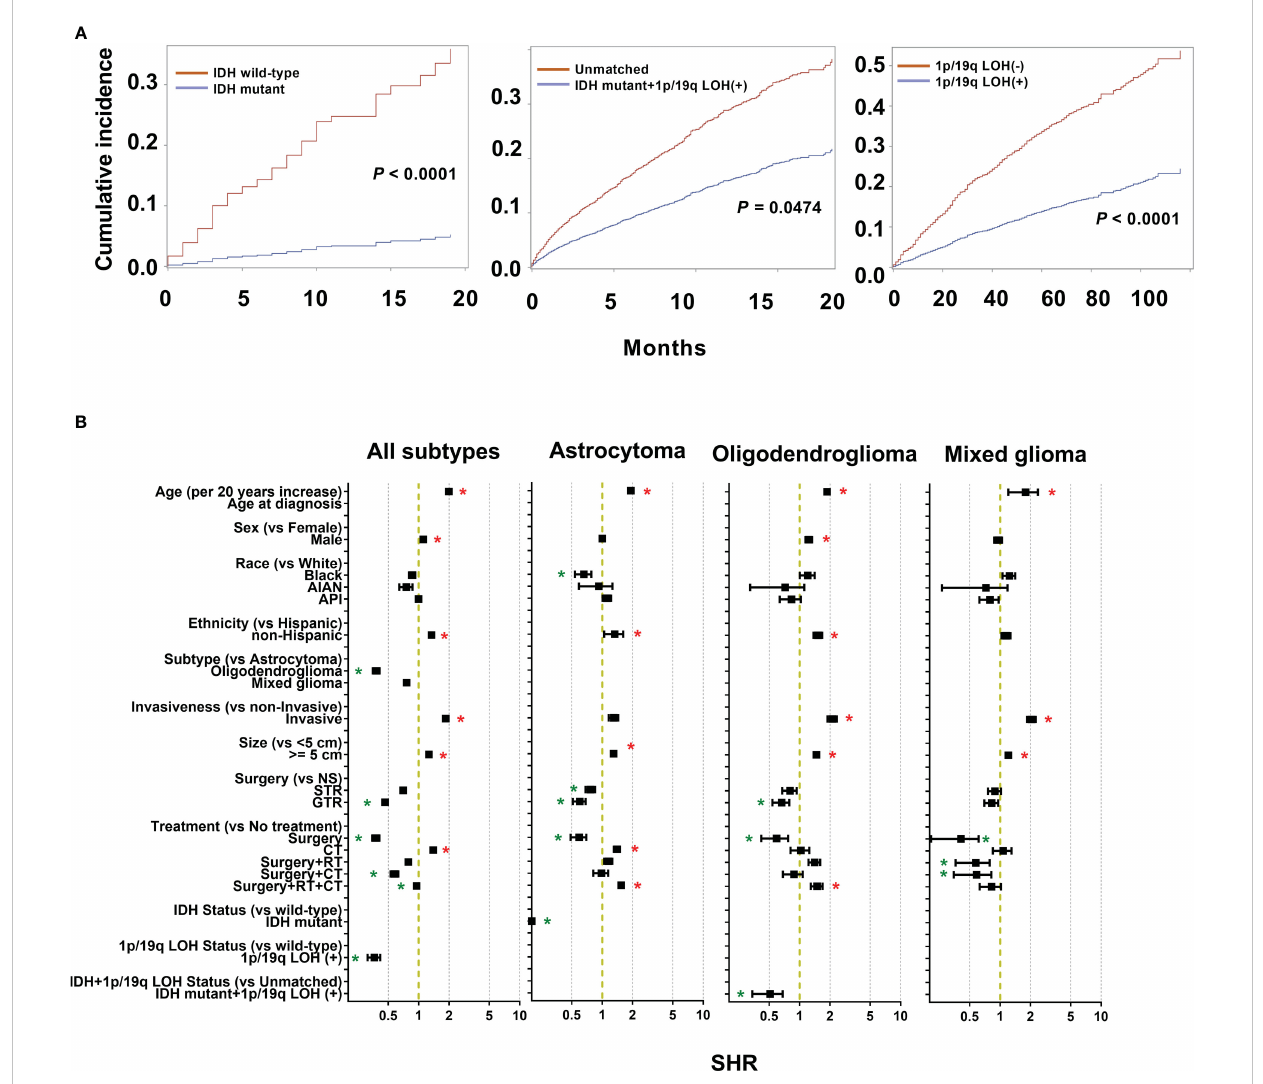
FIGURE 3 Cumulative incidence curves and sub-distribution hazard ratios (SHR) for each of the features of the survival model. (A) The subsequent plots present fraction of the population that has died from low grade gliomas (LGGs) by IDH mutations and 1p/19q codeletion status. (B) SHR by patient demographics (sex, age, race, and ethnicity), tumor (histological subtypes, invasiveness, size), treatment (extent of resection and treatment modality), and molecular markers (IDH mutation and 1p/19q codeletion status) in competing risk regression model for LGG-speci fi c survival. * P <